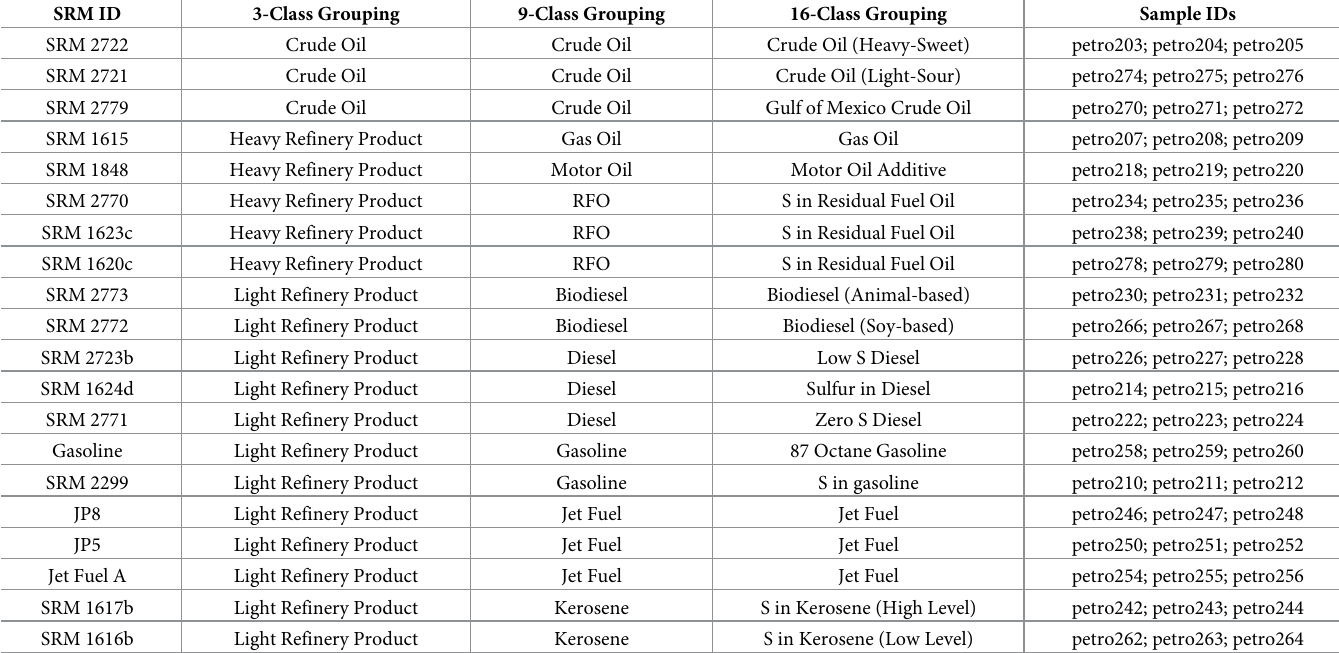
Table 1. Standard Reference Materials (SRM) samples from de Carvalho Rocha, Schantz (14). SRM